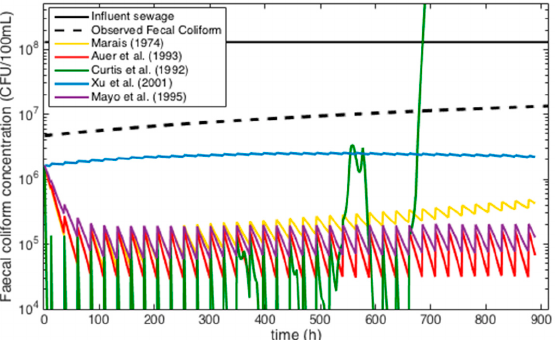
Figure 5. Observed fecal coliform concentrations (CFU/100 mL) compared with predicted concentrations by various disinfection models over the treatment season.